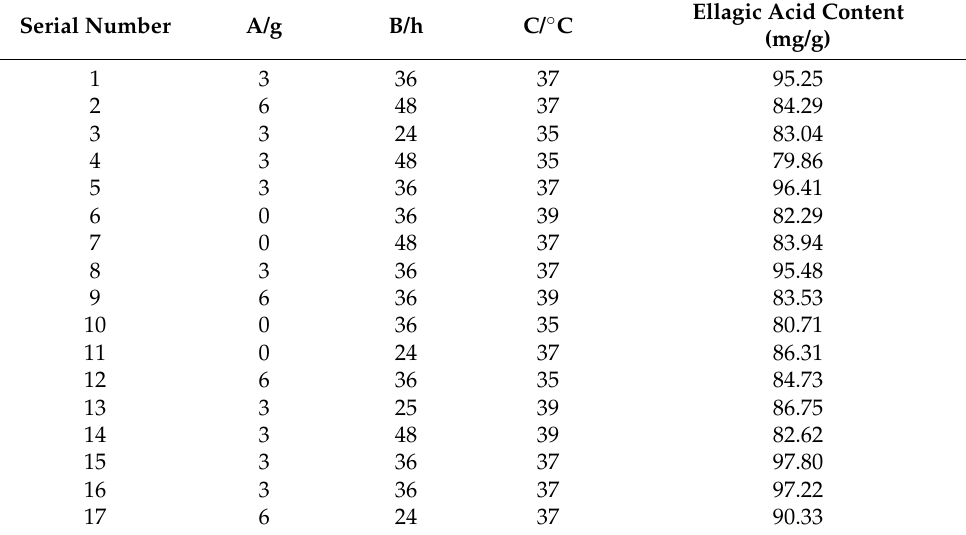
Table 1. Response surface design and experimental results.